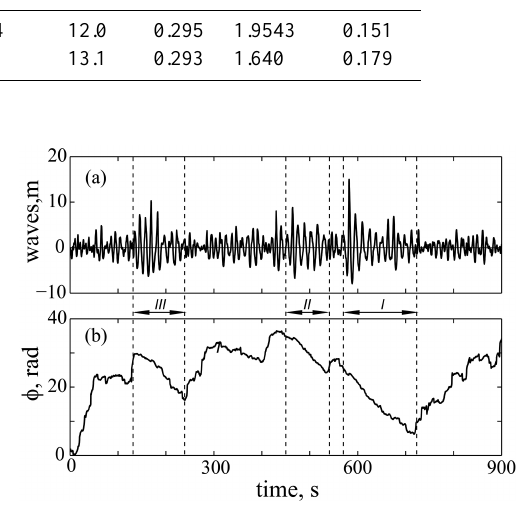
Figure 1. Andrea freak wave. (a) Series measured at 00:40UTC on 9 November 2007; (b) phase ϕ in time.